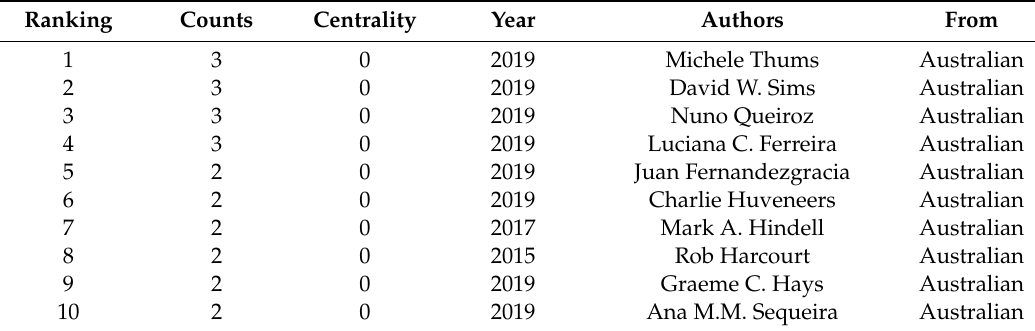
Table 3. Top 10 most productive authors of big ocean data